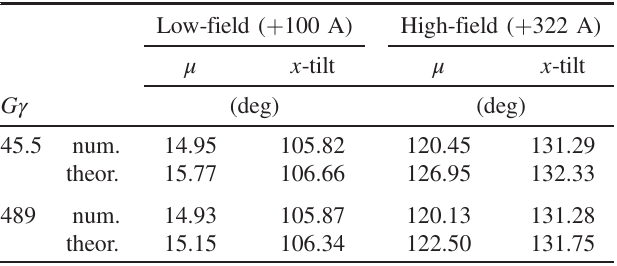
TABLE I. Spin rotation ( μ ), and angle of precession axis to the vertical axis ( x -tilt), in low-field ( B 0 ¼ 1 . 337 T) and high-field ( B 0 ¼ 4 . 07 T) RHIC snake helices, from their OPERA field maps (num.) and from theory (theor.) for